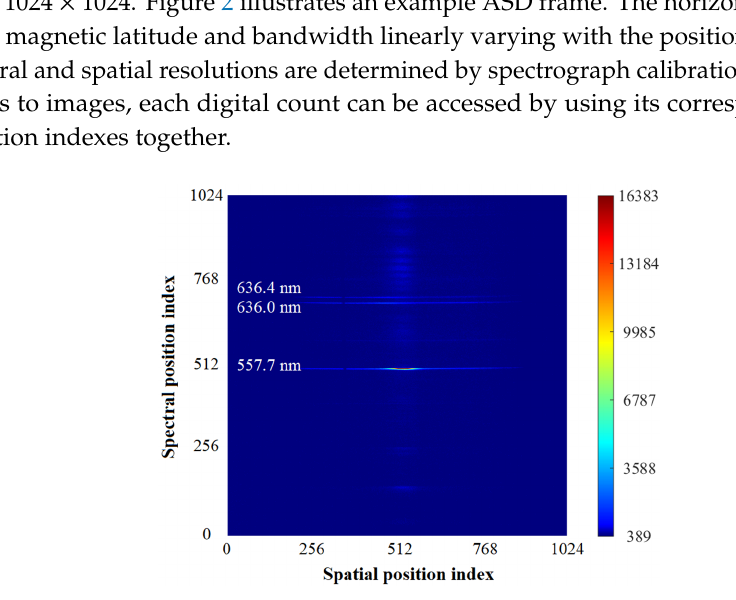
Figure 2. Illustration of the aurora spectral data (ASD) frame acquired at Universal Time (UT) 15:41:14 on28 March 2014, at ZHS.